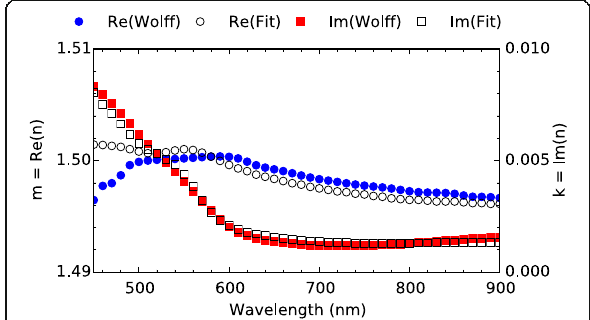
Fig. 1 Complex refractive index of Martian dust plotted against wavelength. Observational results ( filled symbols ) reported by Wolff et al. (2009) are compared with our fitting results ( open symbols ). In this example, the fitting leads to a silicate complex refractive index of n 0 = 1.48 − 0.000942 i and a hematite volume mixing ratio of ρ A =